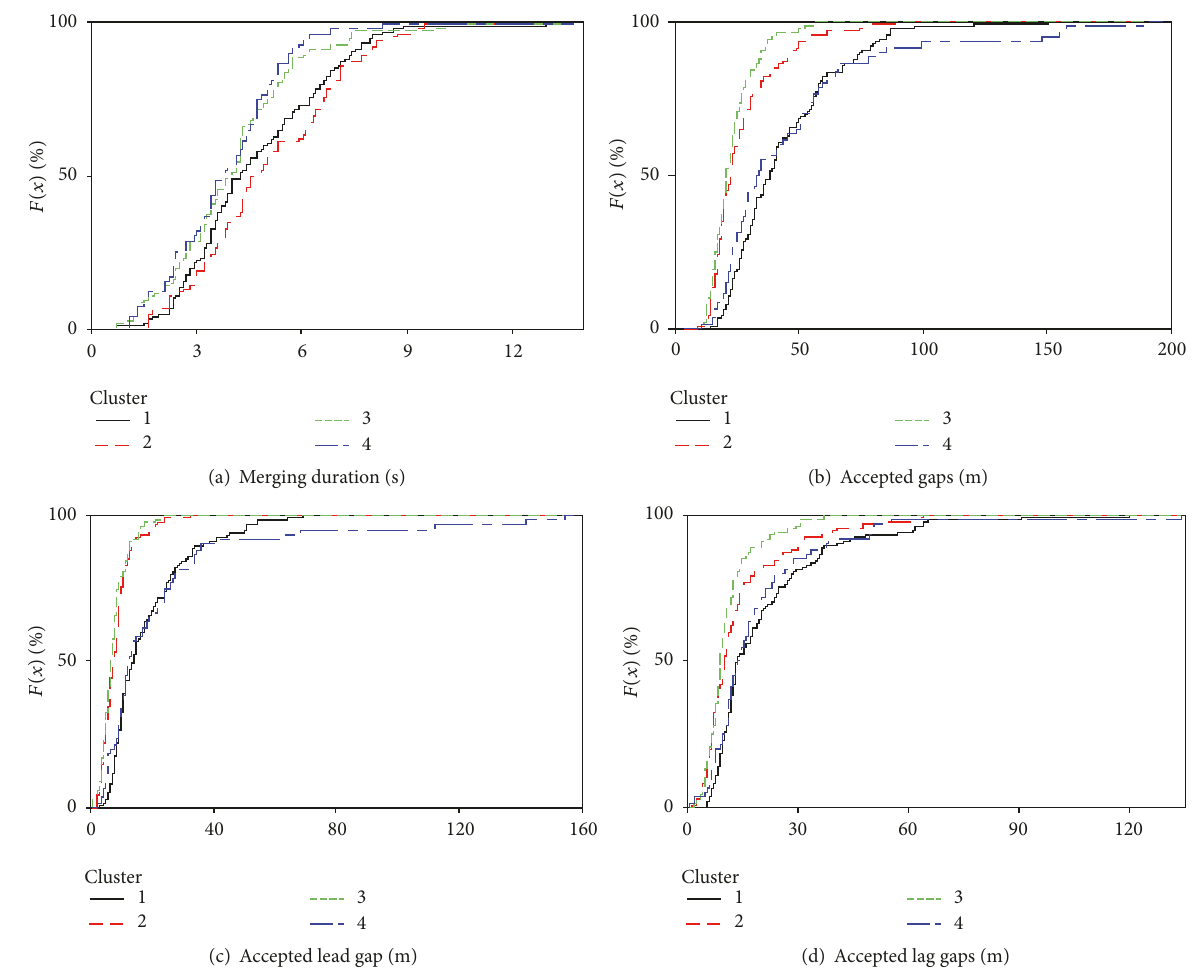
Figure 5: Cumulative distributions of (a) merging position (m), (b) merging speed (m/s), and (c) merging duration (s) for different clusters.